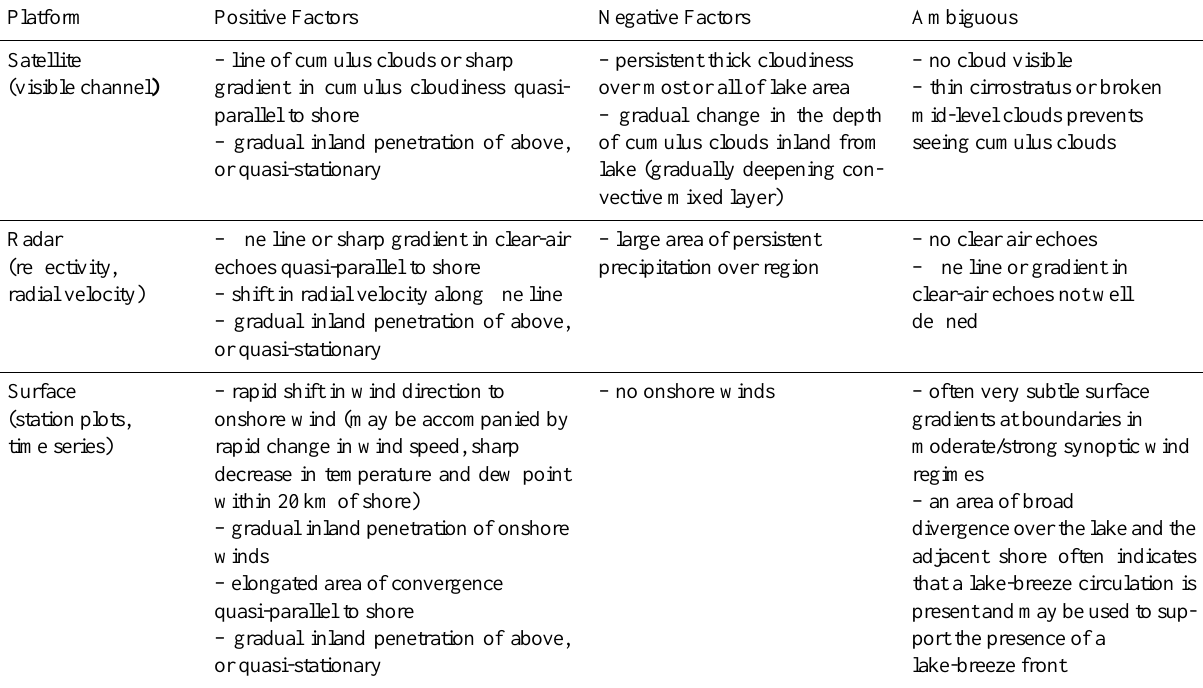
Table 1. Lake breeze identification criteria based on three different observation platforms, including positive, negative, and ambiguous